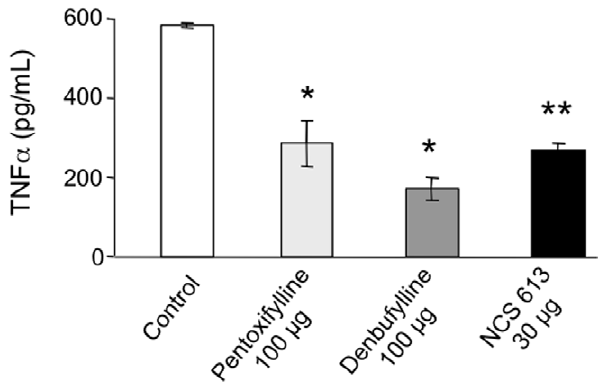
Figure 6. PDE inhibitor treatment effects on ex vivo LPS- induced TNF a secretion by PBLs from MRL/lpr mice. Four groups of 7 MRL/lpr mice each were injected i.v. at 5, 7, 9 and 13 weeks with either 100 m L of PBS-10% ethanol (control), or 100 m g pentoxifylline in 100 m L PBS-10% ethanol, or 100 m g denbufylline in 100 m L PBS-10% ethanol, or 30 m g NCS 613 in 100 m L PBS-10% ethanol. Blood samples were collected from 14 week-old treated mice. PBLs pooled from seven mice of each group were purified and cultured in the presence of LPS, and TNF a secretion was determined by ELISA 24 h later. The results are expressed as the mean concentration (pg/mL) 6 s.e.m. of duplicate cultures. *, P , 0.05; **, P , 0.01.